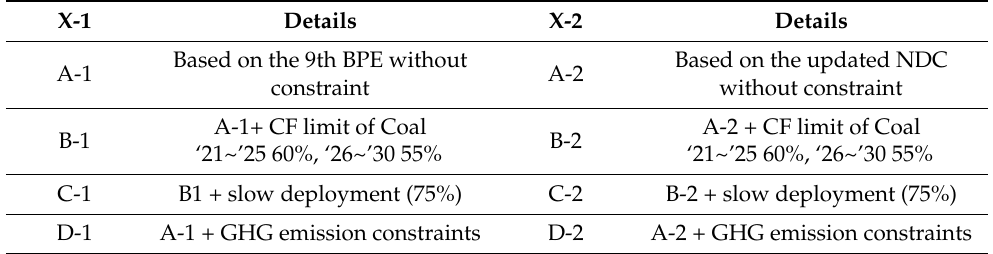
Table 6. Scenario design for emission